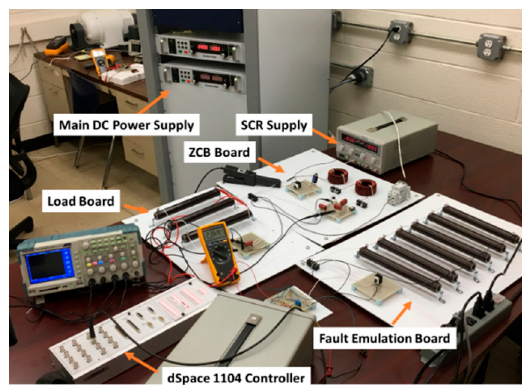
Figure 6. The layout of the ICC-BZCB prototype and its connections to laboratory equipment.